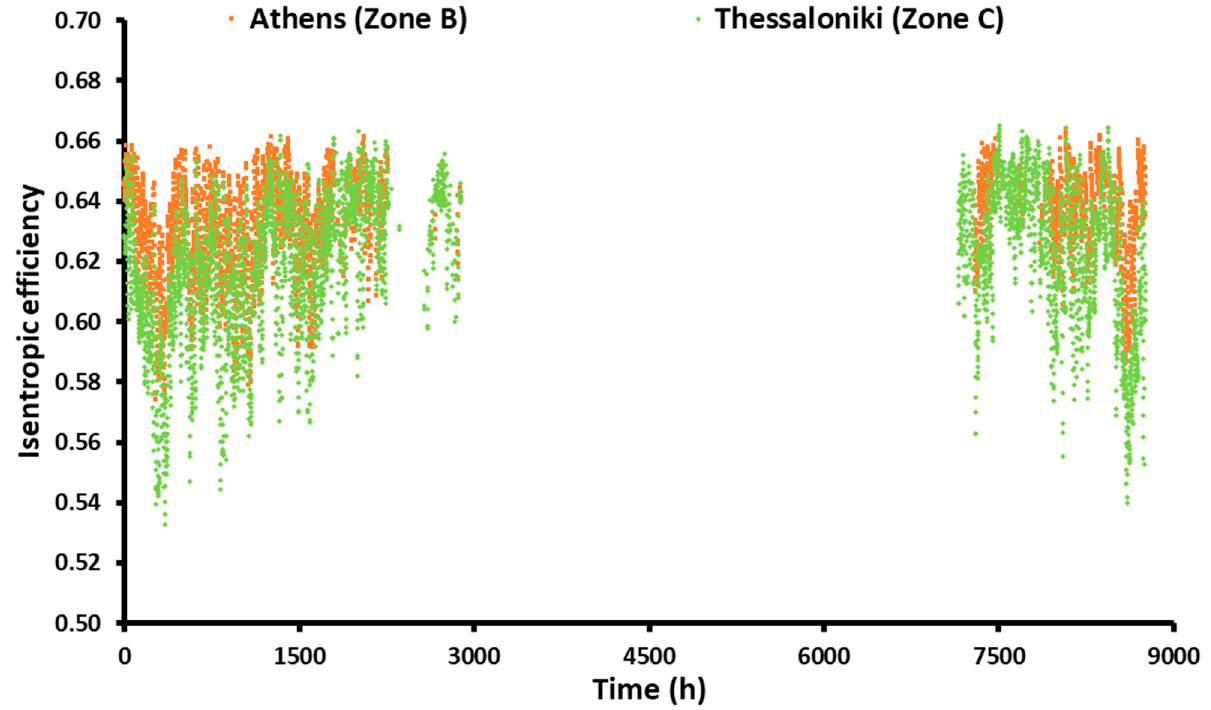
Figure 11. Heat pump system: variation in the compressor isentropic efficiency during the year of operation for the examined locations.